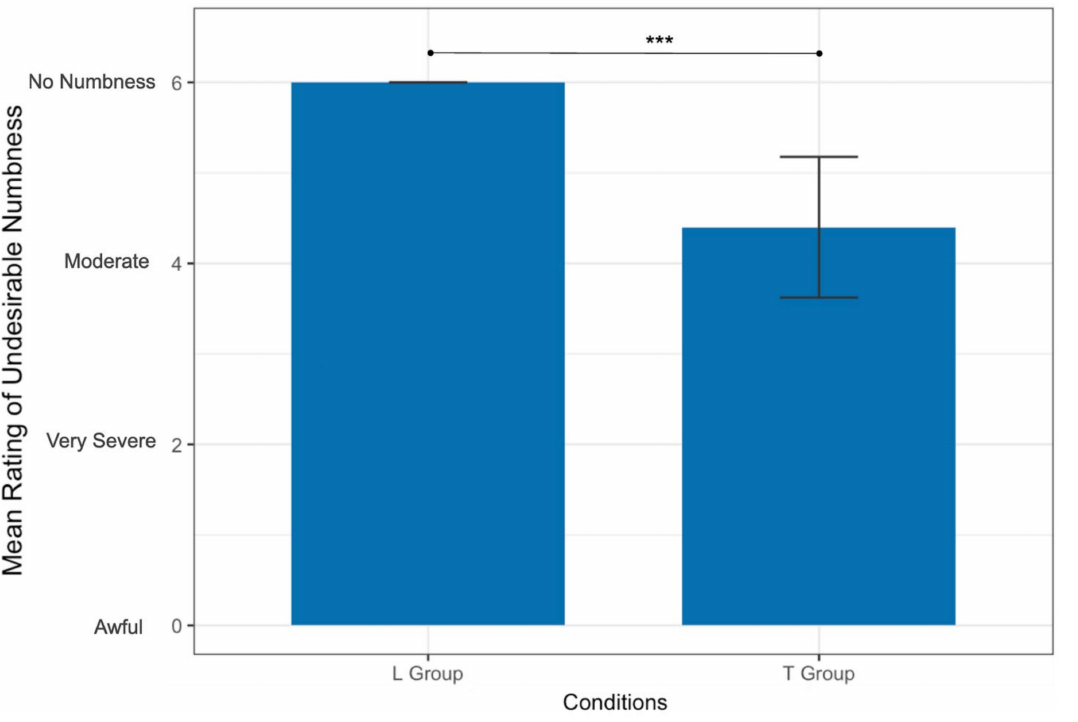
Figure 5. Illustrating the mean ratings of undesirable numbness with associated standard deviation for both groups (L and T), where 0 represents awful and 6 represents no undesirable numbness. Abbreviations: T Group: 20% benzocaine topical gel + placebo laser; L Group: photobiomodula- tion + placebo gel. [***] represents significance at the p < 0.001